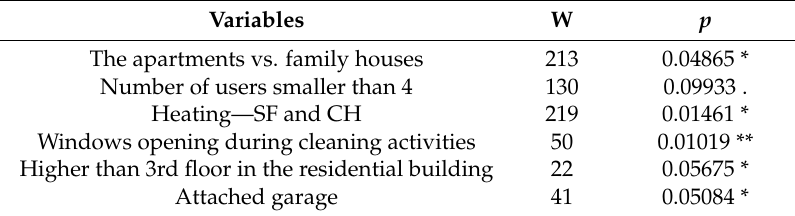
Table 3. Results from Wilcoxon rank sum